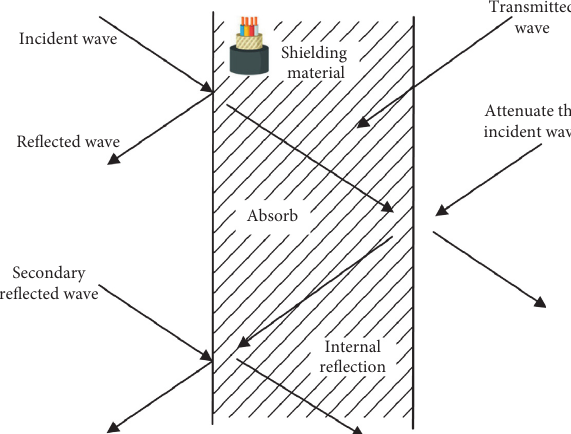
Figure 1: Attenuation principle of shielding material to electromagnetic wave.